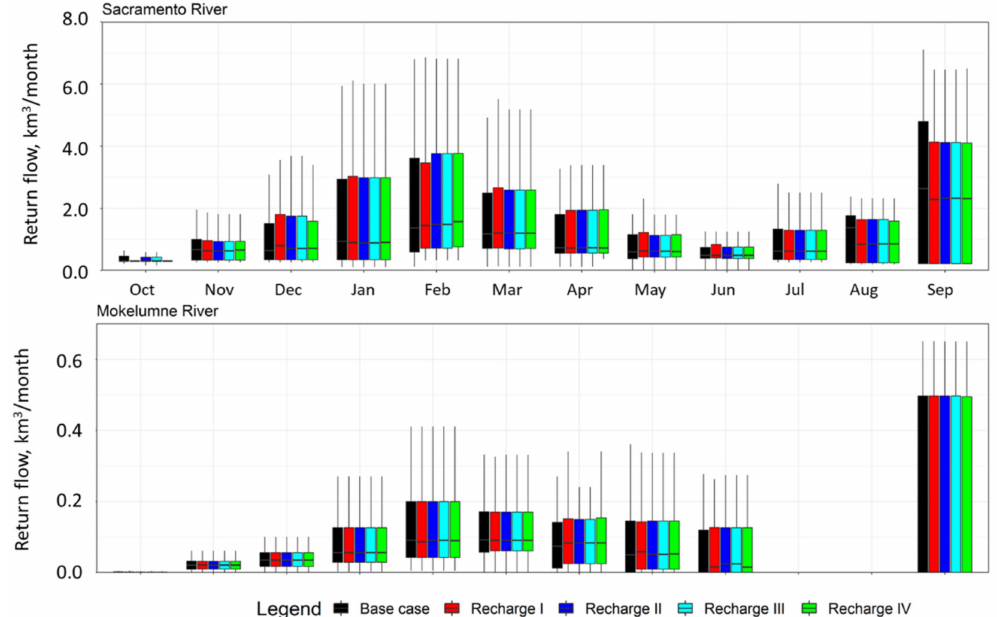
Figure 7. Monthly surface water return flows to Sacramento River ( top ) and Mokelumne River ( bottom ), showing the impact of recharge flow.